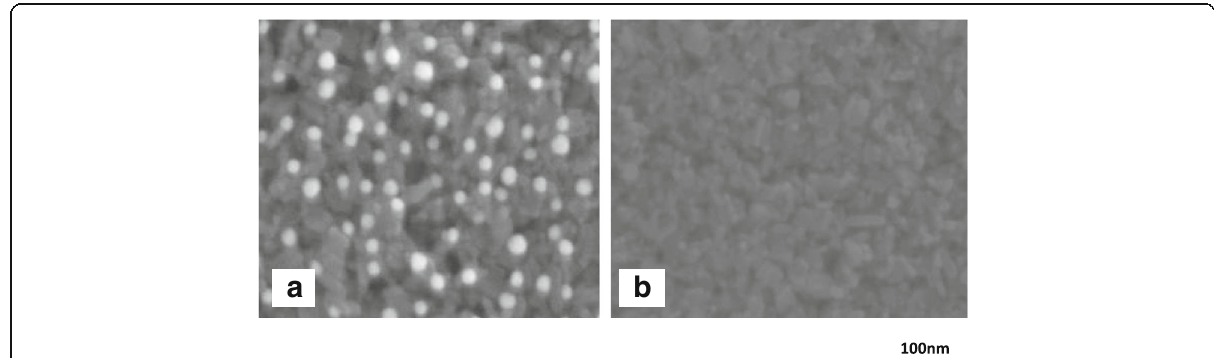
Fig. 3 SEM images of the surfaces of TiO 2 layers a with and b without GNPs. GNPs were formed by dropping the solution containing ~ 40 nm GNPs on the surfaces of TiO 2 layers and